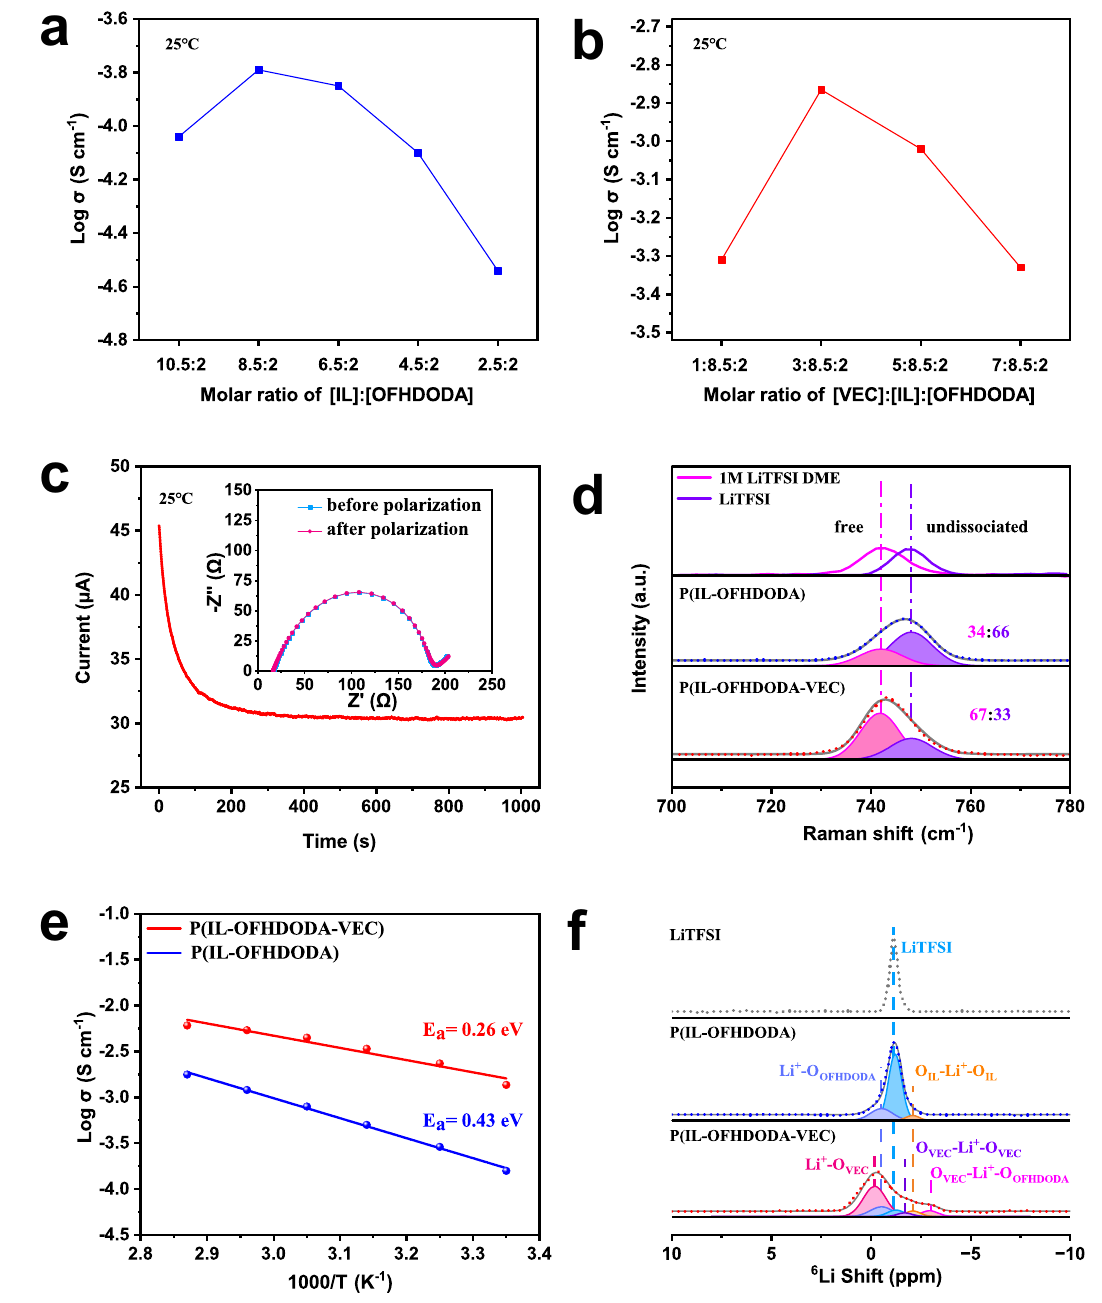
Fig. 2 | Ionic transport properties of SPEs. a , b Ionic conductivity of P(IL-OFH- DODA) ( a ) and P(IL-OFHDODA-VEC) ( b ) at 25°C with different monomer molar ratios. c CAcurveduringpolarizationofLi|P(IL-OFHDODA-VEC)|Lisymmetricalcell at 25°C with total applied potential difference of 10mV. Inset: EIS of Li|P(IL-